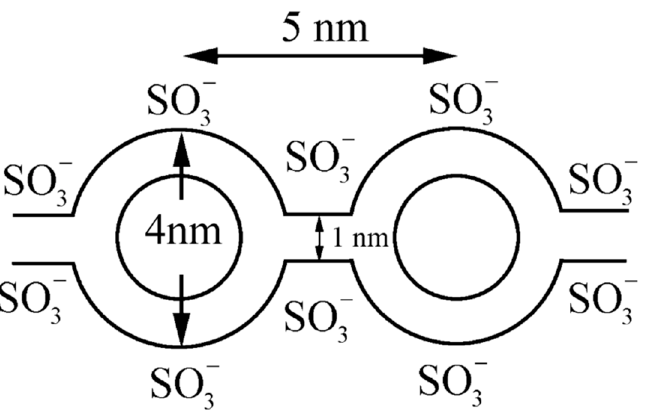
Figure 3. The schematic diagram of spherical micelles formed by a sulfonic acid group.